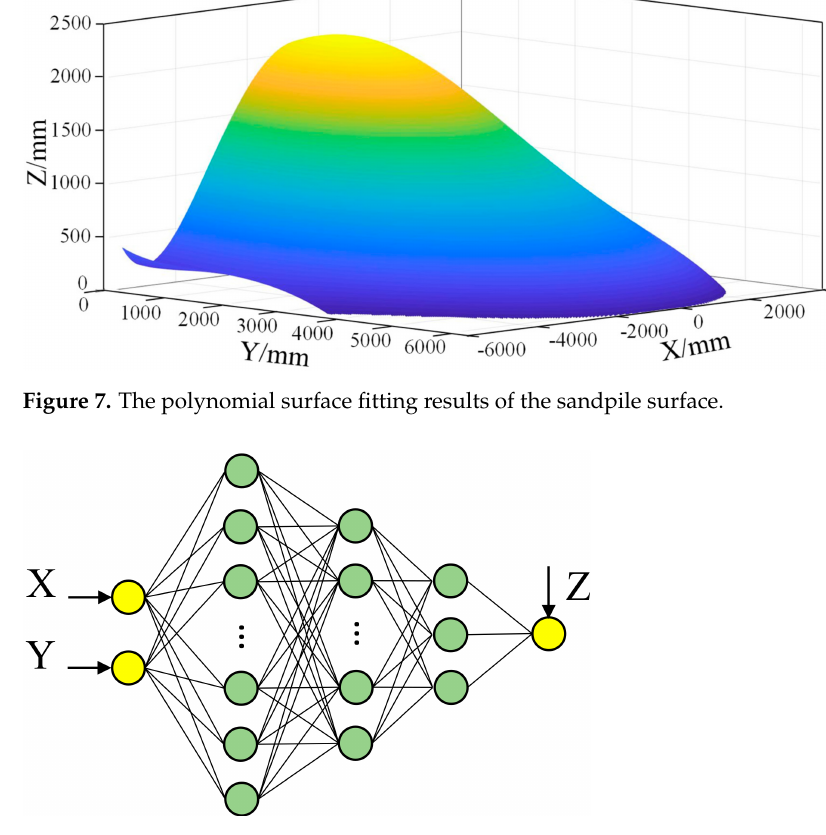
Figure 8. The structure of the neural network.